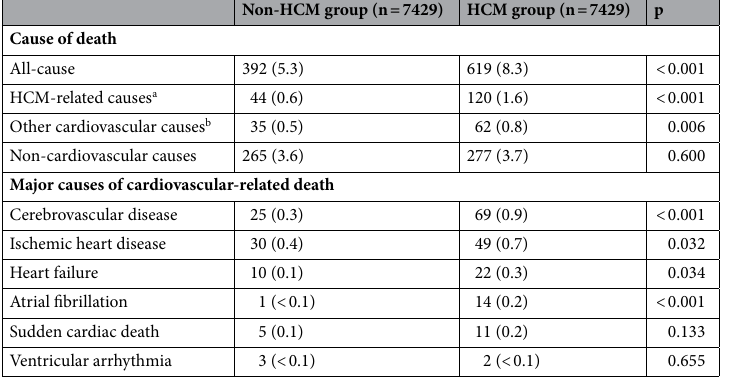
Table 2. Mortality according to cause of death. Data are n (%). HCM hypertrophic cardiomyopathy. a Including atrial fibrillation, cerebrovascular disease, heart failure, sudden cardiac death, arterial thromboembolism, and ventricular arrhythmia. b Including hypertensive disease, ischemic heart disease, and peripheral arterial disease.